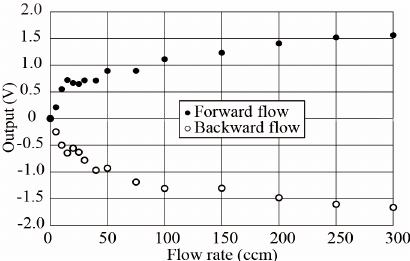
Figure 8. Subtracted value between two temperature sensors. (Output = temperature sensor 1 − temperature sensor